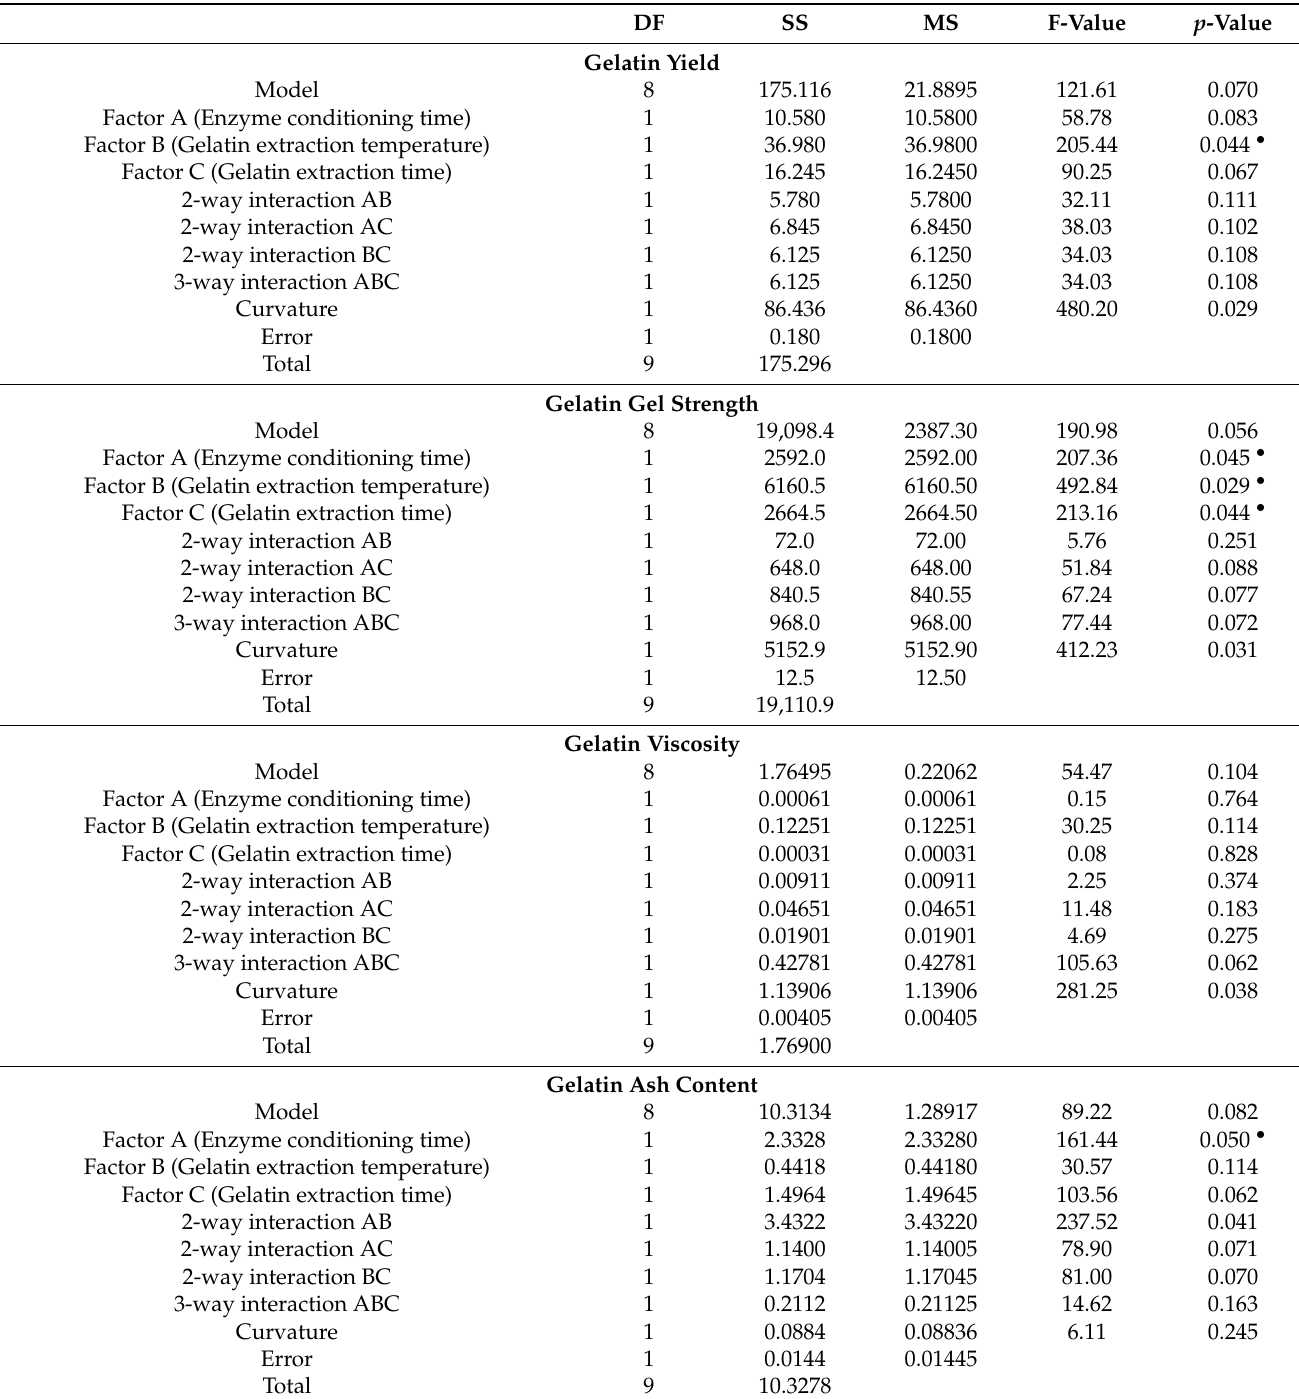
Table 2. Analysis of variance of the experimental design for gelatin yield, gelatin gel strength, gelatin viscosity and gelatin ash